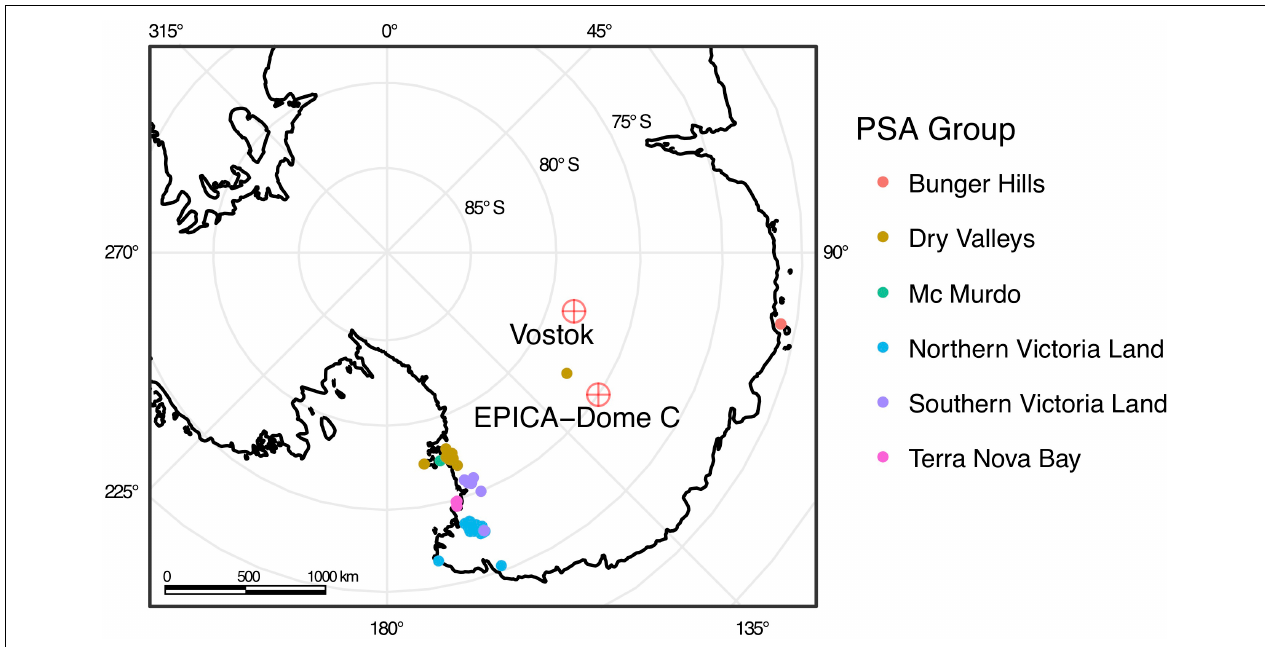
FIGURE 1 | Location map of the Vostok and EPICA Dome-C ice cores sites and PSA samples studied for magnetic properties (see Supplementary Material for details on